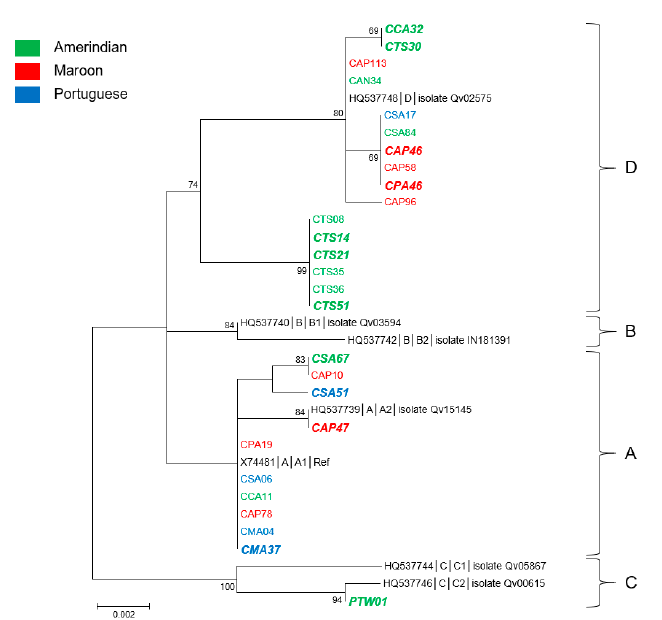
Figure 4. Phylogenetic tree of HPV52 variants from French Guiana. Maximum likelihood phylogenetic tree of HPV52 variants based on 741 bp of E6 and E7 concatenated sequences. Four clusters were identified as lineages A, B, C, and D. Only bootstrap values above 70% are represented in the branches. The tree is drawn to scale, with branch lengths measured in the number of substitutions per site. Newly generated sequences, here identified by their IDs, are color-coded according to the mother tongue of the women from whom they were obtained. Oversized sequences in bold and in italics are those obtained from women with an abnormal cytology (either ASCUS, ASC-H, LSIL, HSIL, or glandular anomalies).